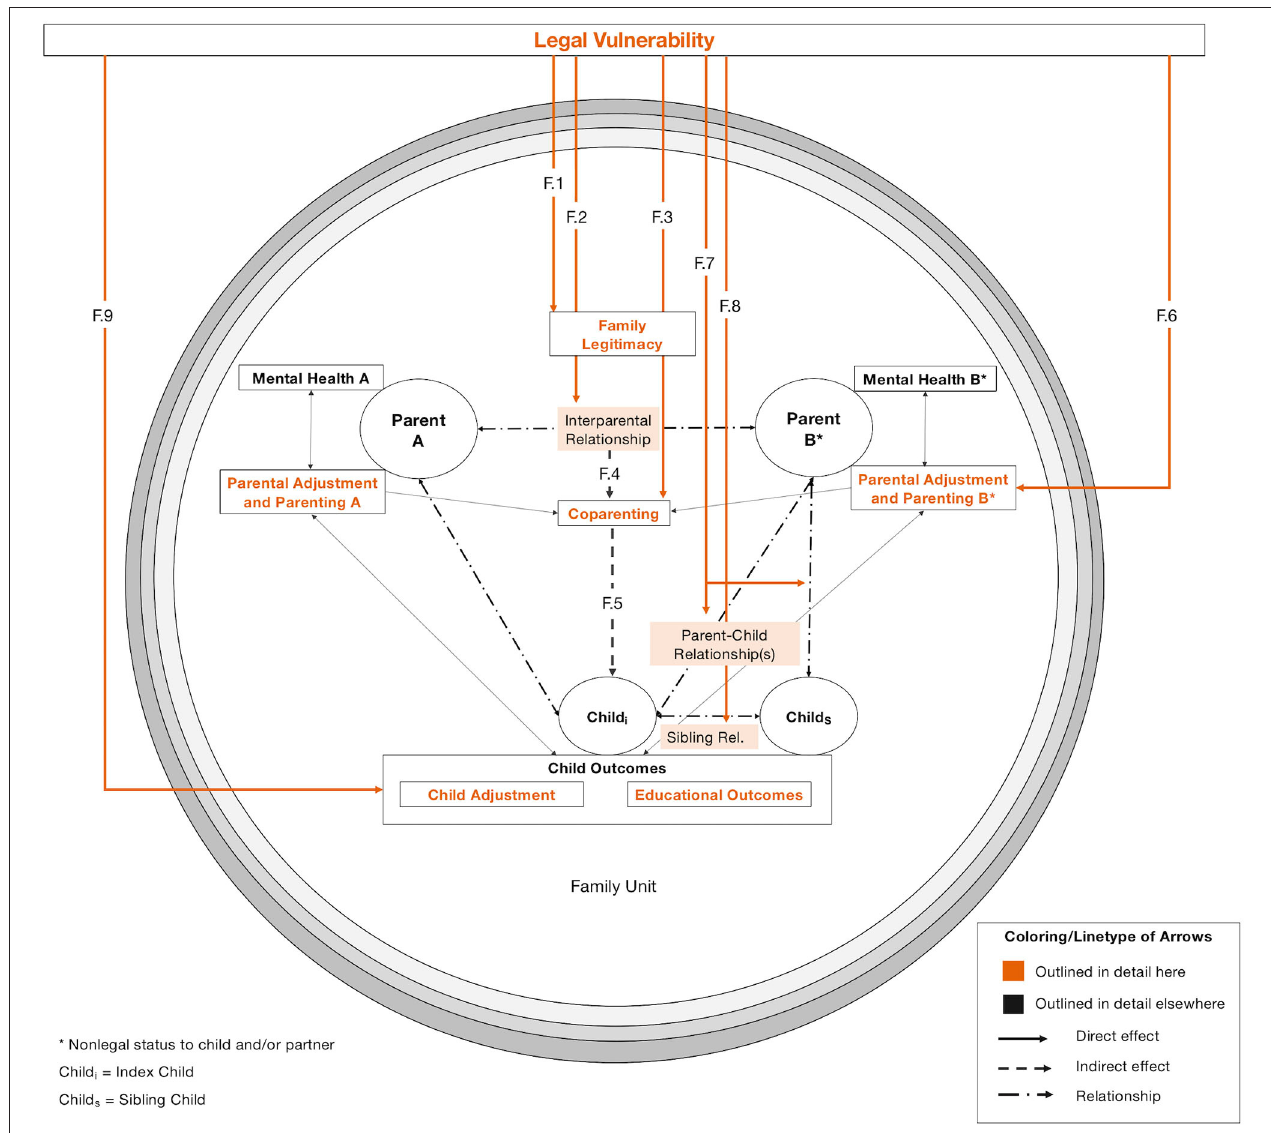
FIGURE 4 | Impact of legal vulnerability on family functioning and child outcomes. Colored arrows (orange) are outlined in detail here and depict empirically testable relations between constructs (highlighted with colored headings), not evidence strength. Dashed lines depict indirect effects of legal vulnerability (i.e., through other constructs). Thin, unlabeled arrows (e.g., between parental adjustment and coparenting) depict interrelations between constructs outlined elsewhere. Boxes colored in orange as well as dot-dashed-lines depict relationships between family members. Note that legal vulnerability is depicted outside the family unit for clarity. Terminology was chosen in line with Feinberg